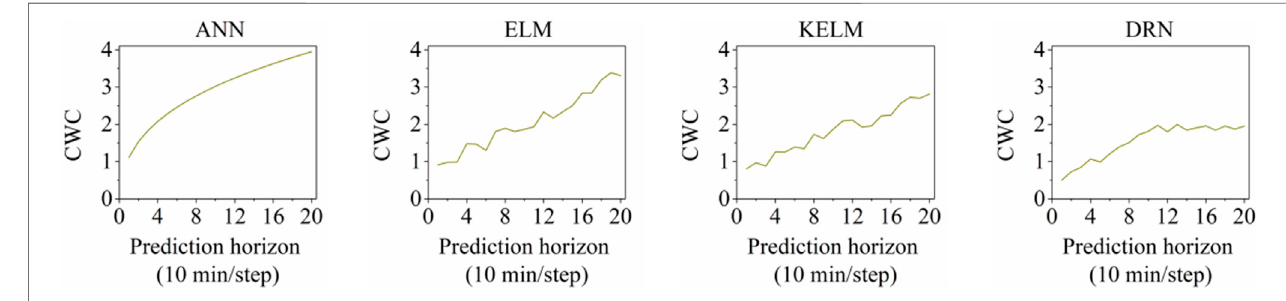
FIGURE 3 | Changes of CWC at different prediction